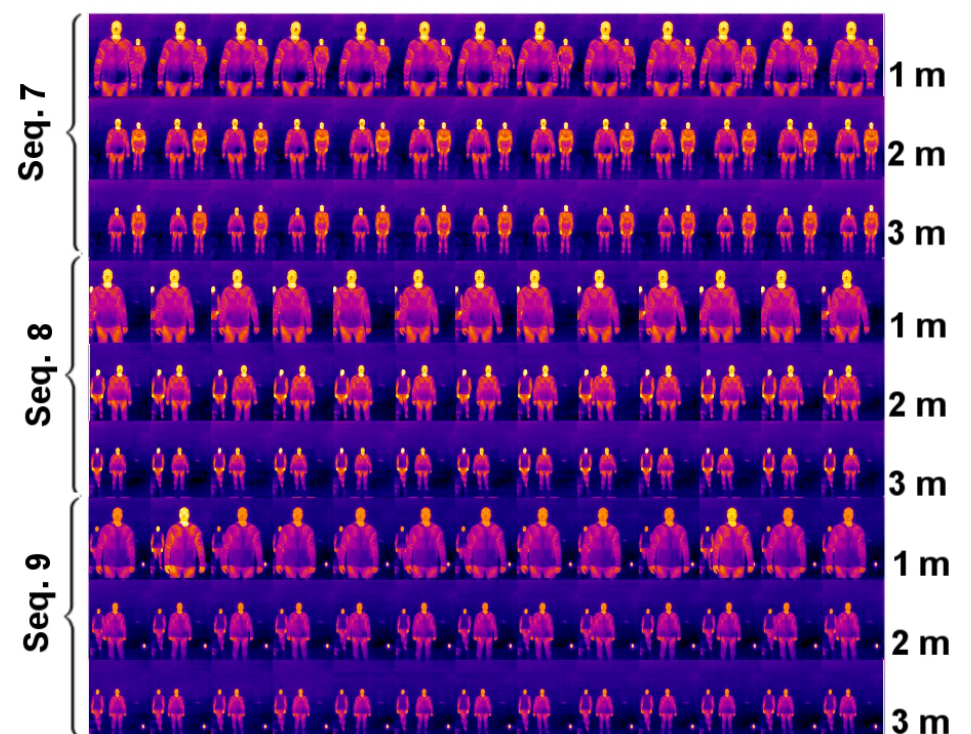
Figure 8. Sample frames from test set (7, 8, 9) at different distances (1, 2, 3 m)—two people and small warm object.